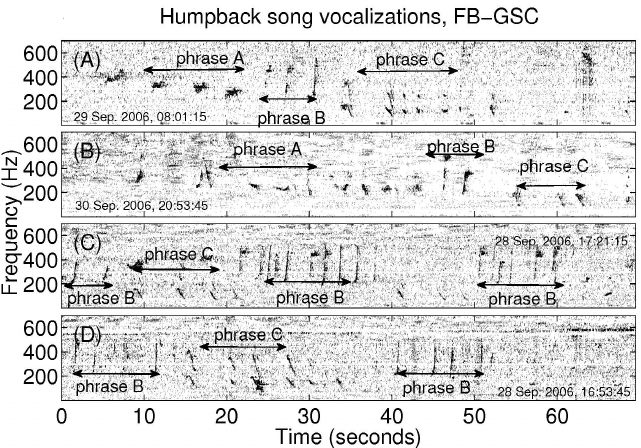
Figure 3. Examples of beamformed spectrograms containing humpback song vocalizations originating from the FB-GSC direction drawn from both day and nighttime recordings in the 27 September to 3 October 2006 observation period in the Gulf of Maine, starting at ( A ) 08:01:15 EDT on 29 September 2006; ( B ) 20:53:45 EDT on 30 September 2006; ( C ) 17:21:15 EDT on 28 September 2006 and ( D ) 16:53:45 EDT on 28 September 2006 and each lasting roughly 70 seconds. The humpback song vocalizations are composed of repetitive phrases A, B and C.